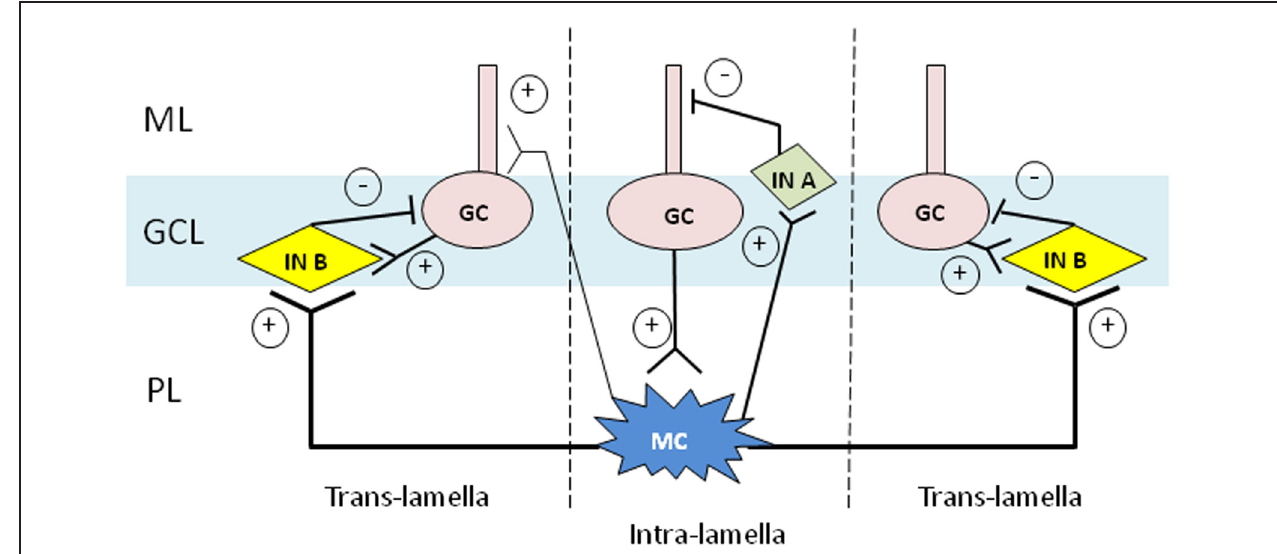
FIGURE 2 | Two hypothetical modes for mossy cell-driven feed-forward inhibition of granule cells. Based on our findings, dentate granule cells appear to be inhibited by two distinct categories of interneurons in light of fast- or slow-rise kinetics of postsynaptic GABA A receptors. We propose that granule cells located in the same lamellae receive inhibition from interneurons (In A; interneuron A) which display slow-rise time kinetics of sIPSCs at the granule cell dendrites.